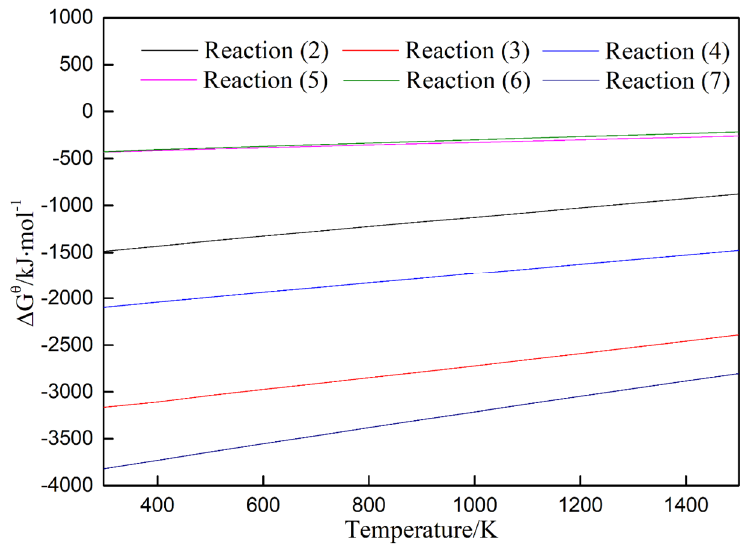
Figure 8. Changes in standard Gibbs free energy (ΔG θ ) of the reactions (2)–(7) with the temperature.